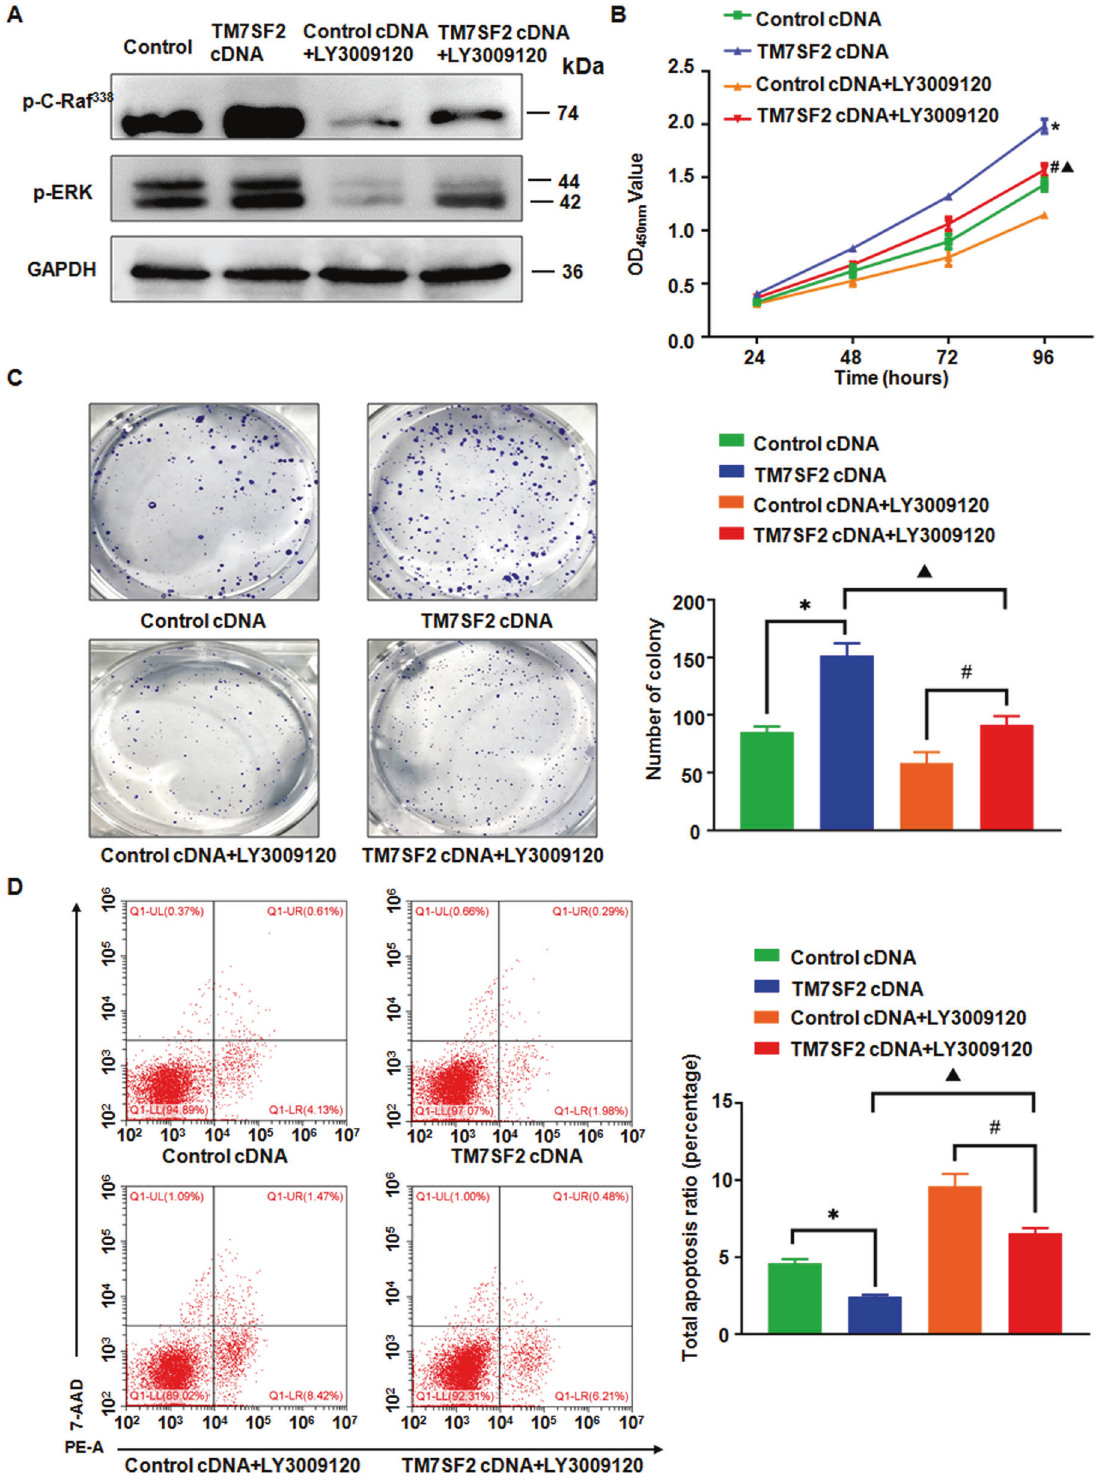
Fig. 6 TM7SF2 modulates cell proliferation and apoptosis via C-Raf/ERK signaling pathway in cervical cancer cells. A The inhibitory effect of C-Raf/ERK pathway after treatment with Raf inhibitor LY3009120 in C33A cells. B , C CCK-8 assay and colony formation assay showed that LY3009120 reversed TM7SF2-induced promotion of proliferation in C33A cells. D The fl ow cytometry assay showed that LY3009120 treatment rescued the suppression of apoptosis by TM7SF2 overexpression in C33A cells. * p < 0.05 compared to control cDNA, # p < 0.05 compared to control cDNA + LY3009120, Δ p < 0.05 compared to TM7SF2